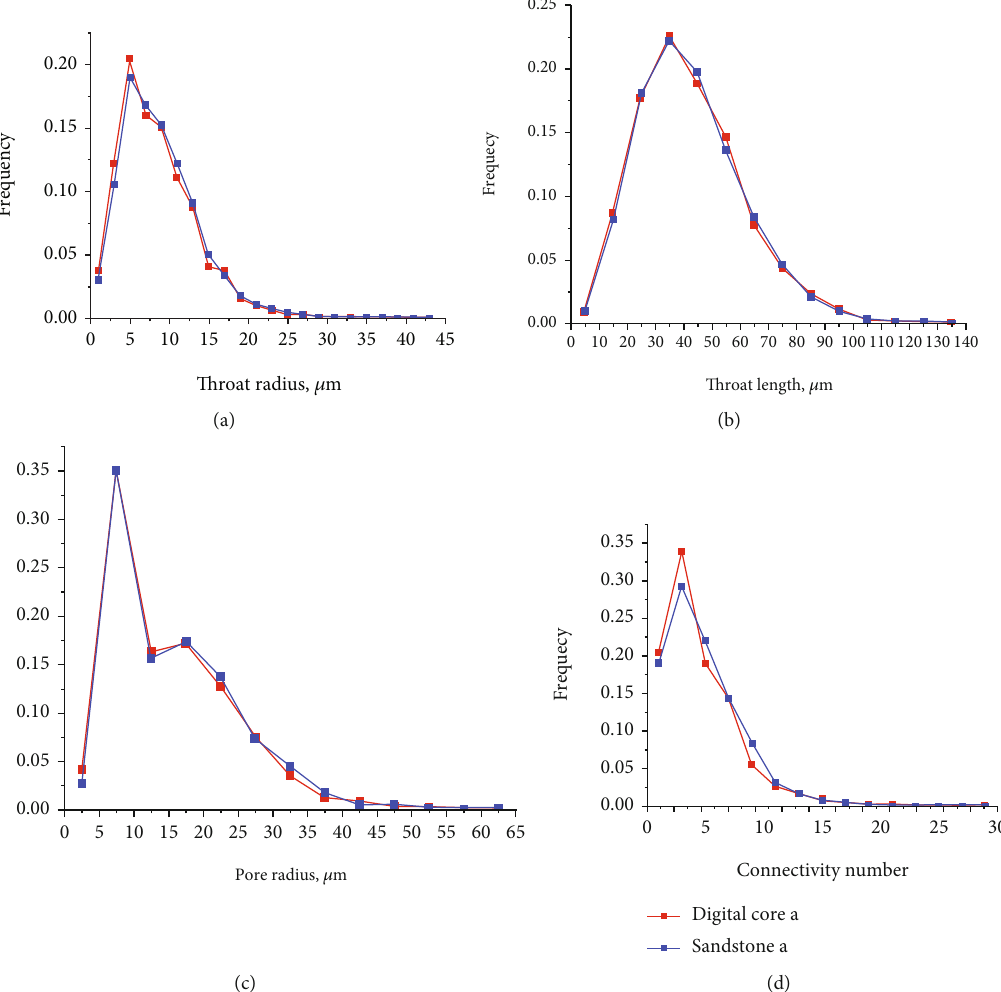
Figure 16: Pore-throat parameters of digital core a and sandstone a: (a) throat radius; (b) throat length; (c) pore radius; (d) connectivity